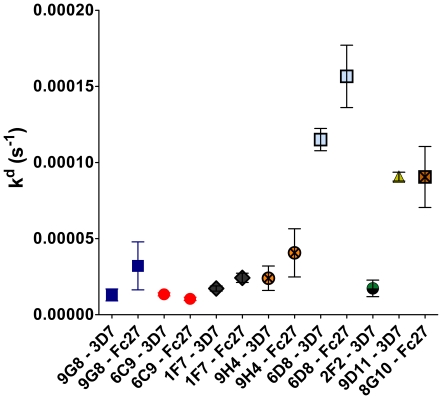
kd values for monoclonal antibodies against MSP2.Comparison of affinity response of the mAbs against recombinant MSP2-FC27 and MSP2-3D7 proteins. The error bars indicate mean ± SEM.